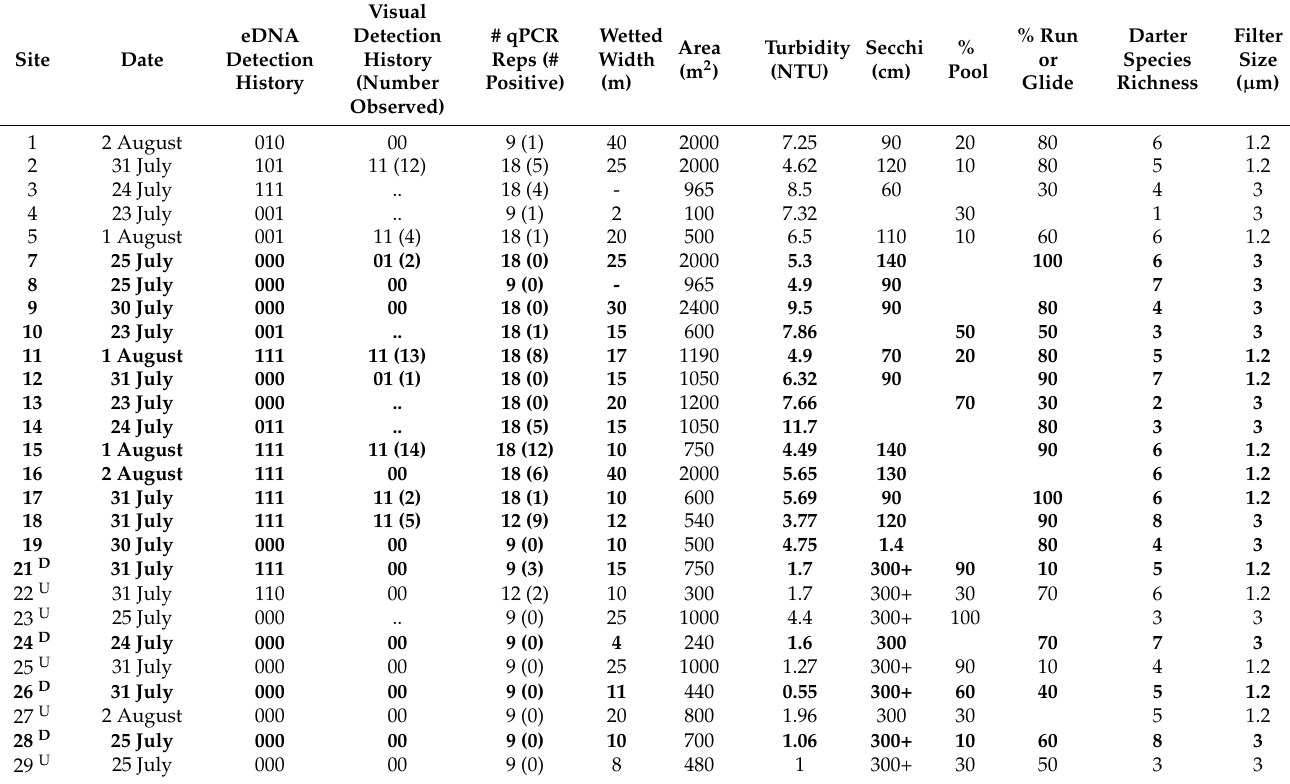
Table 1. Results from environmental DNA (eDNA) and visual surveys for longnose darter Percina nasuta in the St. Francis River, Missouri surveyed in July and August 2018. The eDNA detection history is shown as “0” (negative) and “1” (positive) such that “010” is a positive detection in the second survey and negatives in the first and third surveys. A “..” represents a sample where visual surveys via snorkeling were not conducted but assumed to be zero. Upstream tributary sites are indicated by “ U ” and downstream by “ D ”. Site 6 was not sampled and there was no site 20. Sites used in occupancy analysis are bolded. NTU = Nephelometric turbidity